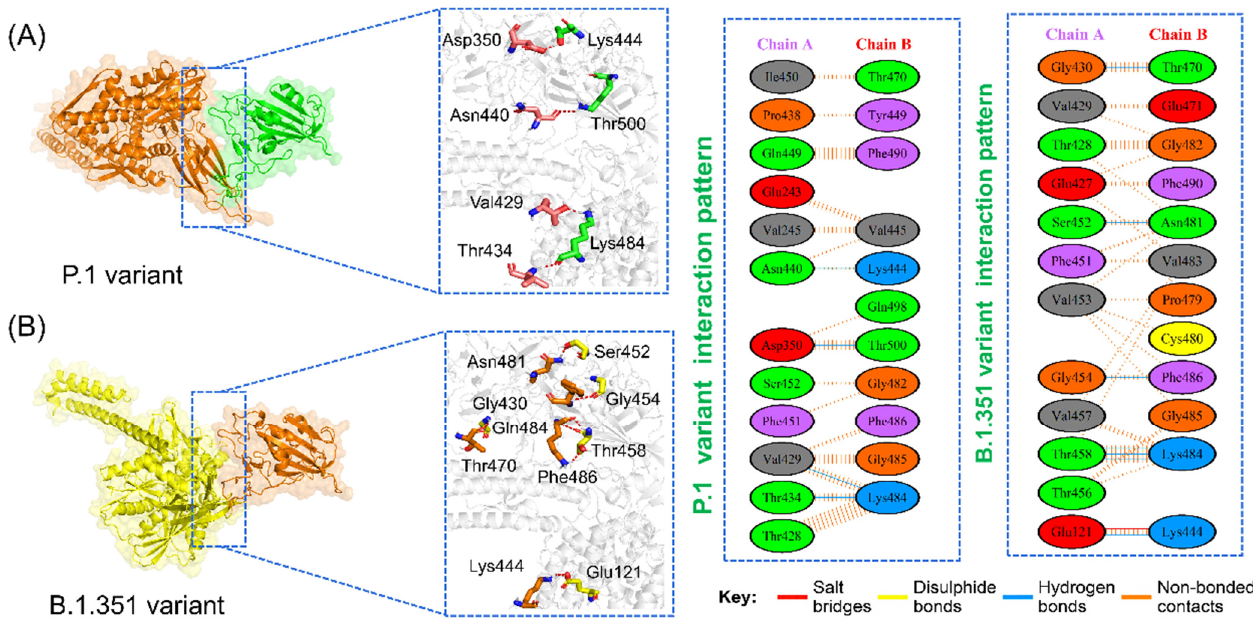
Figure 3. Binding modes of GRP78 and spike RBD of P.1 and B.1.351 variants. ( A ) shows the interaction of GRP78 and RBD of P.1, while ( B ) shows the interaction of GRP78 with B.1.351-RBD. The right panels show the 2D interaction patterns of P.1 and B.1.351.